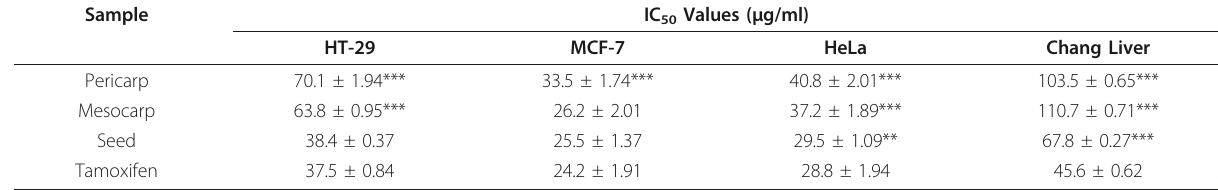
Table 3 The IC 50 values of extracts on HT-29, MCF-7, HeLa and Chang liver cell lines